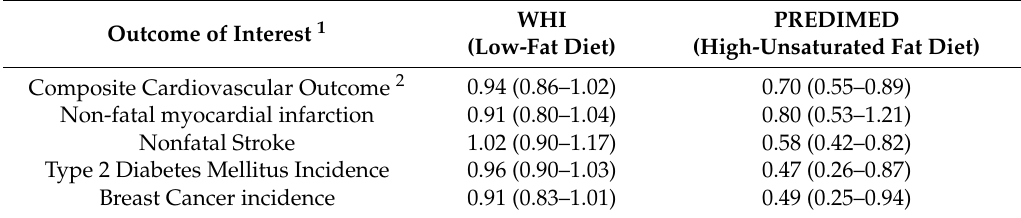
Table 1. Cardiometabolic outcomes comparison of the Prevenci ó n con Dieta Mediterr á nea (PREDIMED) and Women’s Health Initiative Dietary Modification Trial (WHI)